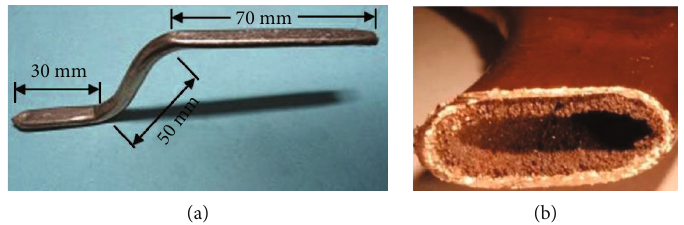
Figure 2: Heat pipe: (a) bent copper-water heat pipe; (b) the metal sintered powder wick.